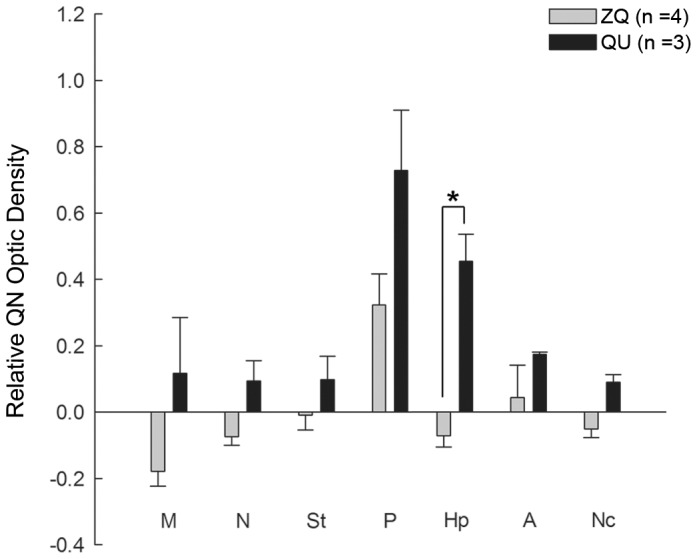
Relative QN staining optical density in the subregions of the forebrains at ED9.QN optic densities in the subregions were normalized by the QN staining density in the tectum. QN optical density of the measured forebrain areas in quail embryos was higher than the optical density in chimera embryos (p<0.001; nonparametric two way ANOVA; species×selected brain region). *: p<0.004; t-test in the striatum, pallidum and hippocampus and Mann-Whitney rank sum test in the rest of the areas (n = 3 ZQ and 3 QU). Error bars S.E.M.